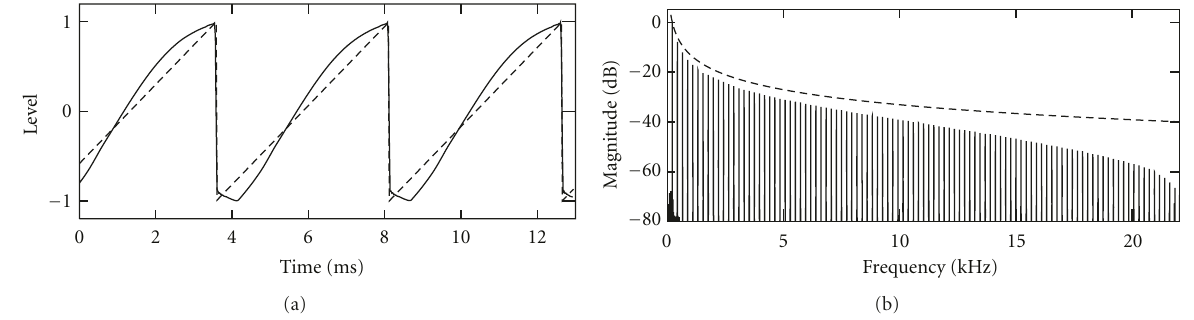
Figure 1: (a) Recorded Moog sawtooth waveform having the fundamental frequency f 0 = 220 . 62Hz. The spectrum of the waveform is shownin (b) together with the approximately − 6 dB per octave spectral envelope of the textbook sawtooth waveform(dashed line). Sampling frequency f s = 44 . 1kHz was used for the recording. In (a), the dashed line represents the textbook sawtooth waveform.